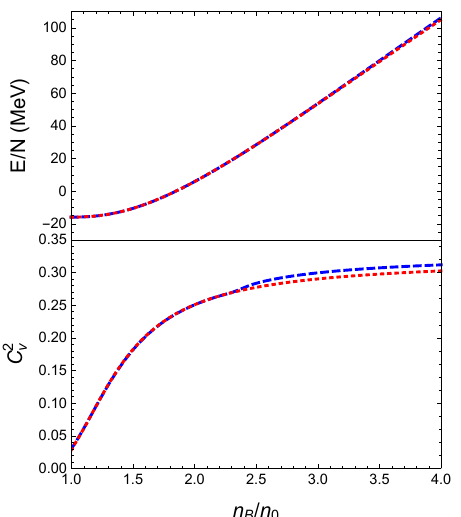
Figure 5 . The energy per nucleon E=N and speed of sound C 2 the range of which corresponds to that of (cid:22) B in (cid:12)gure 4. The conventions are the same as those in (cid:12)gure 1.